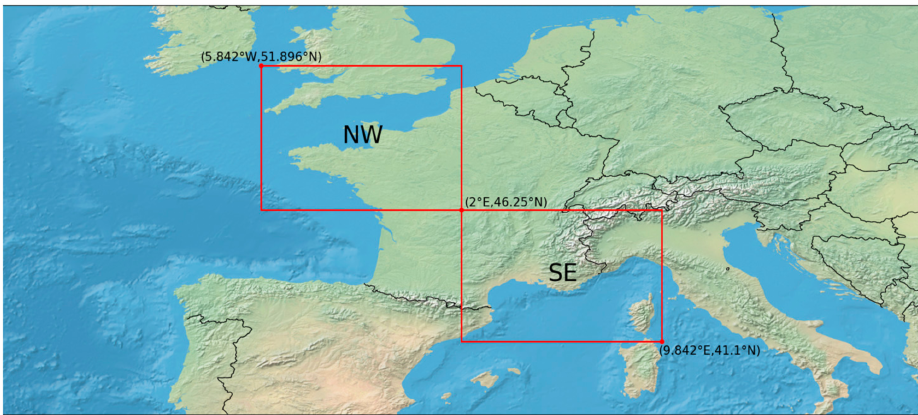
Figure 1. The geographical regions used for the radar reflectivity data (red rectangle). The data were collected using the Doppler radar network of METEO FRANCE, and 3D reflectivity maps were obtained by each radar scanning the sky. The radar’s spatial resolution is 0.01 degrees, and the projection system used is